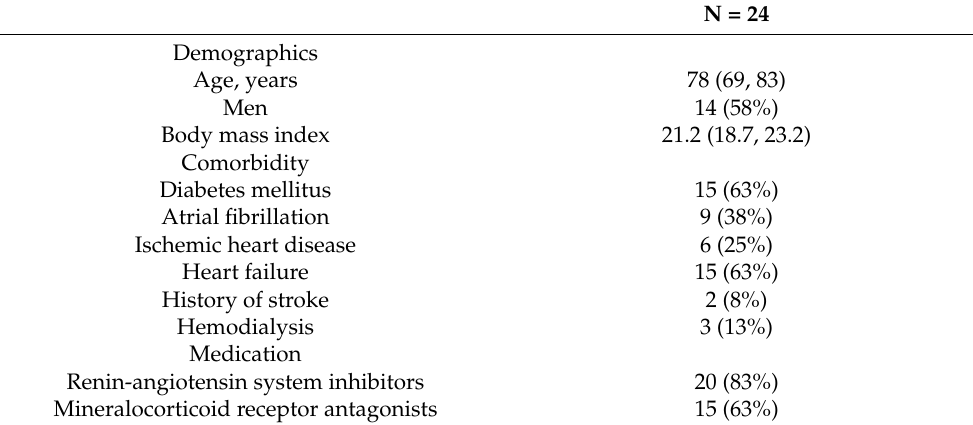
Table 1. Baseline characteristics.